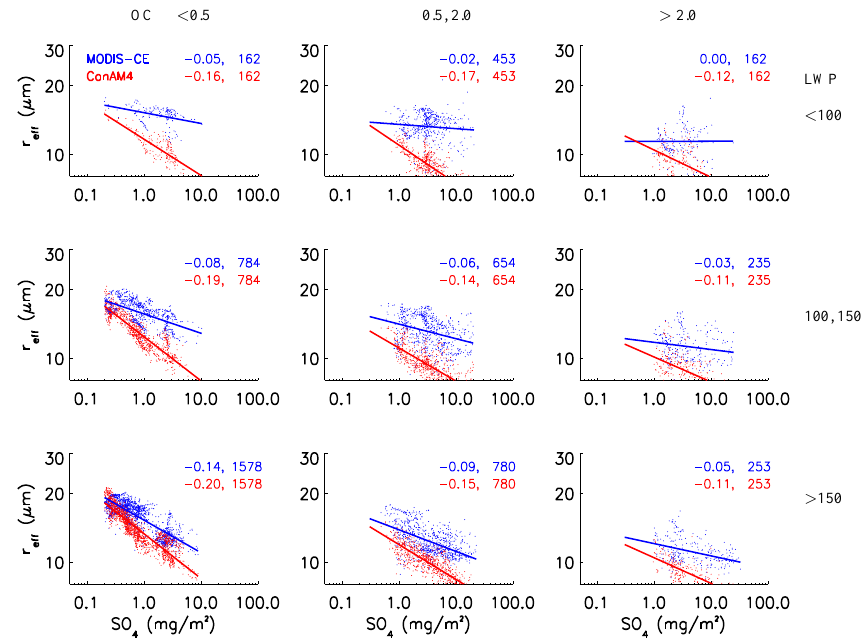
Fig. 8. Same as Fig. 4, but the simulation uses Menon’s parameterization for CDNC.